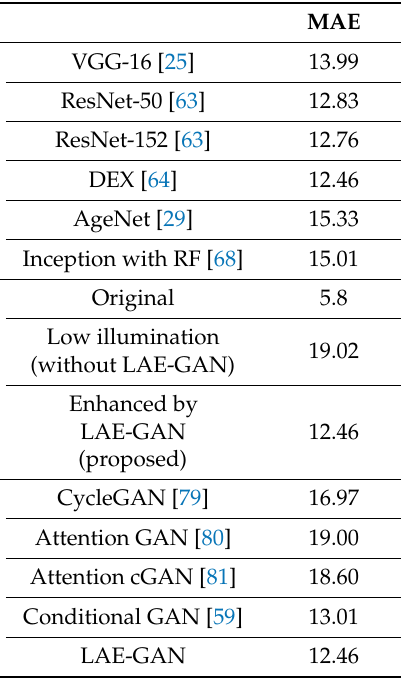
Table 6. Comparisons of age estimation accuracies by various methods on the MORPH database (unit: